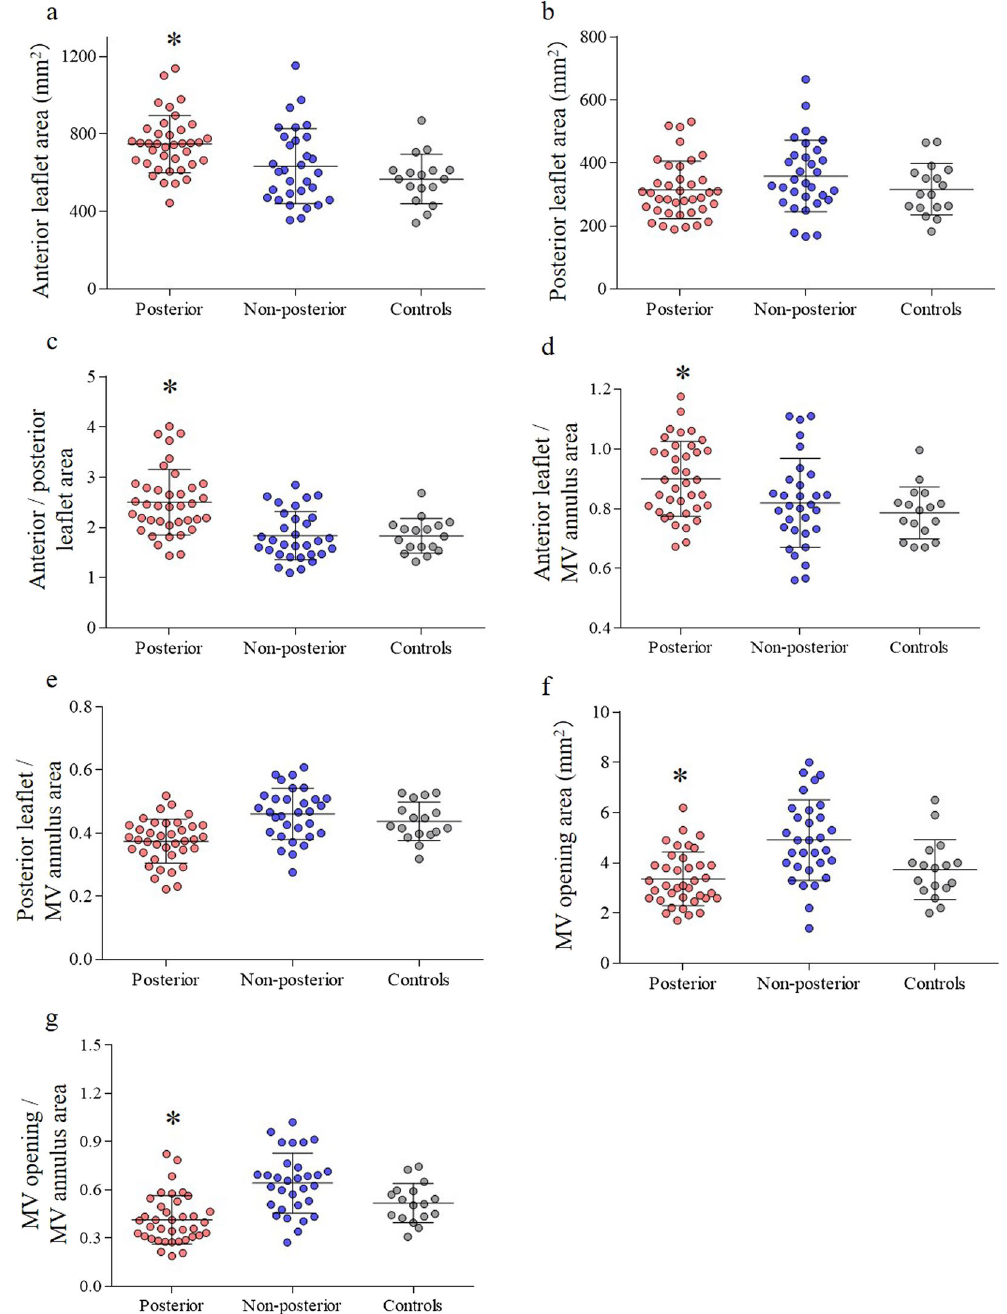
Figure 3. MV geometry measurements in each group and controls. ( a ) AML area ( b ) PML area ( c ) AML area/ PML area ratio ( d ) AML area/MV annulus area ratio ( e ) PML area/MV annulus area ratio ( f ) MV opening area. ( g ) MV opening area/MV annulus area. * P < 0.05 compared with other group and